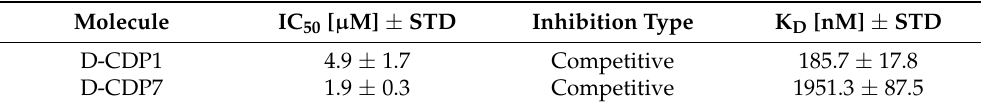
Figure 5. Inhibition effect, dose-response curve, and inhibition mode of D-CDP1 and D-CDP7 over SARS-CoV-2 3CL pro . ( A ): Normalised activity and inhibition of SARS-CoV-2 3CL pro under D-CDP1 influence. ( B ): Normalised activity and inhibition of SARS-CoV-2 3CL pro under D-CDP7 influence. ( C ): Dose-response curve of D-CDP1 and SARS-CoV-2 3CL pro . The normalised response [%] of SARS-CoV-2 3CL pro is plotted against the log of the D-CDP1 concentration. ( D ): Dose-response curve of D-CDP7 and SARS-CoV-2 3CL pro . ( E ): Lineweaver-Burk plot for D-CDP1 inhibition of SARS-CoV-2 3CL pro . [S] is the substrate concentration; v is the initial reaction rate. ( F ): Lineweaver-Burk plot for D-CDP7 inhibition of SARS-CoV-2 3CL pro . Data shown are the mean ± SD from three independent measurements ( n = 3). Table 3. Affinity and Inhibitory Activity of the D-CDP1 and D-CDP-7 Peptides.